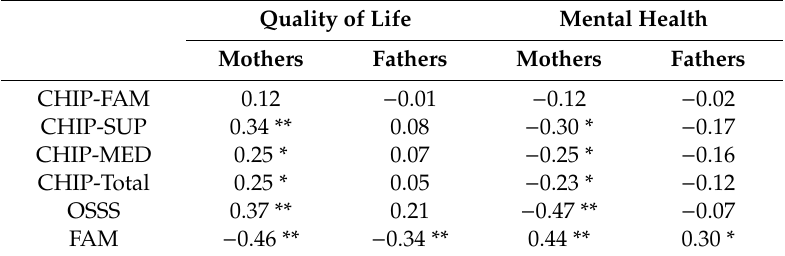
Table 5. Pearson correlation between predictor and outcome